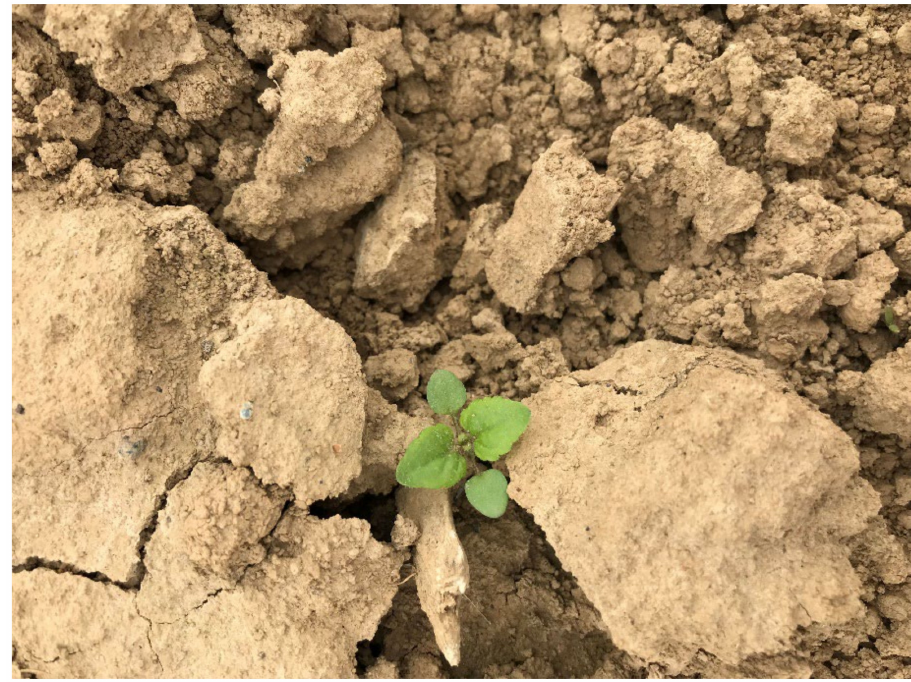
Figure 1. Example picture of Veronica persica , RGB, Detection GoB.